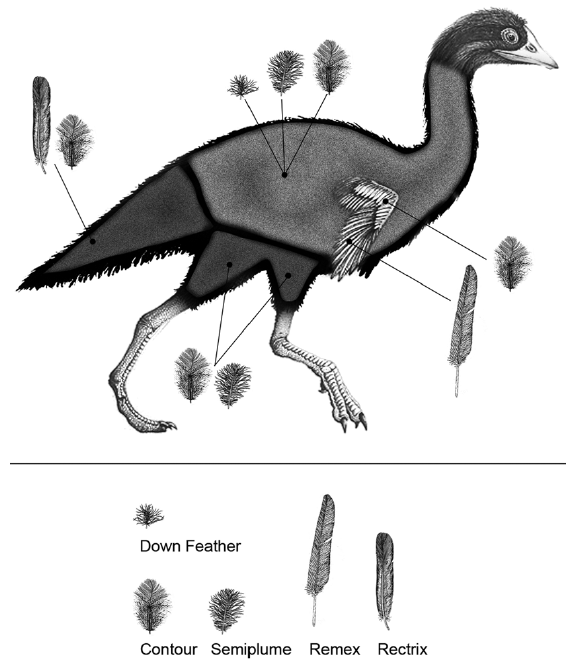
Fig. 4 – Sketch of a hypothetical flightless animal showing the distri- bution of the different feather types in the